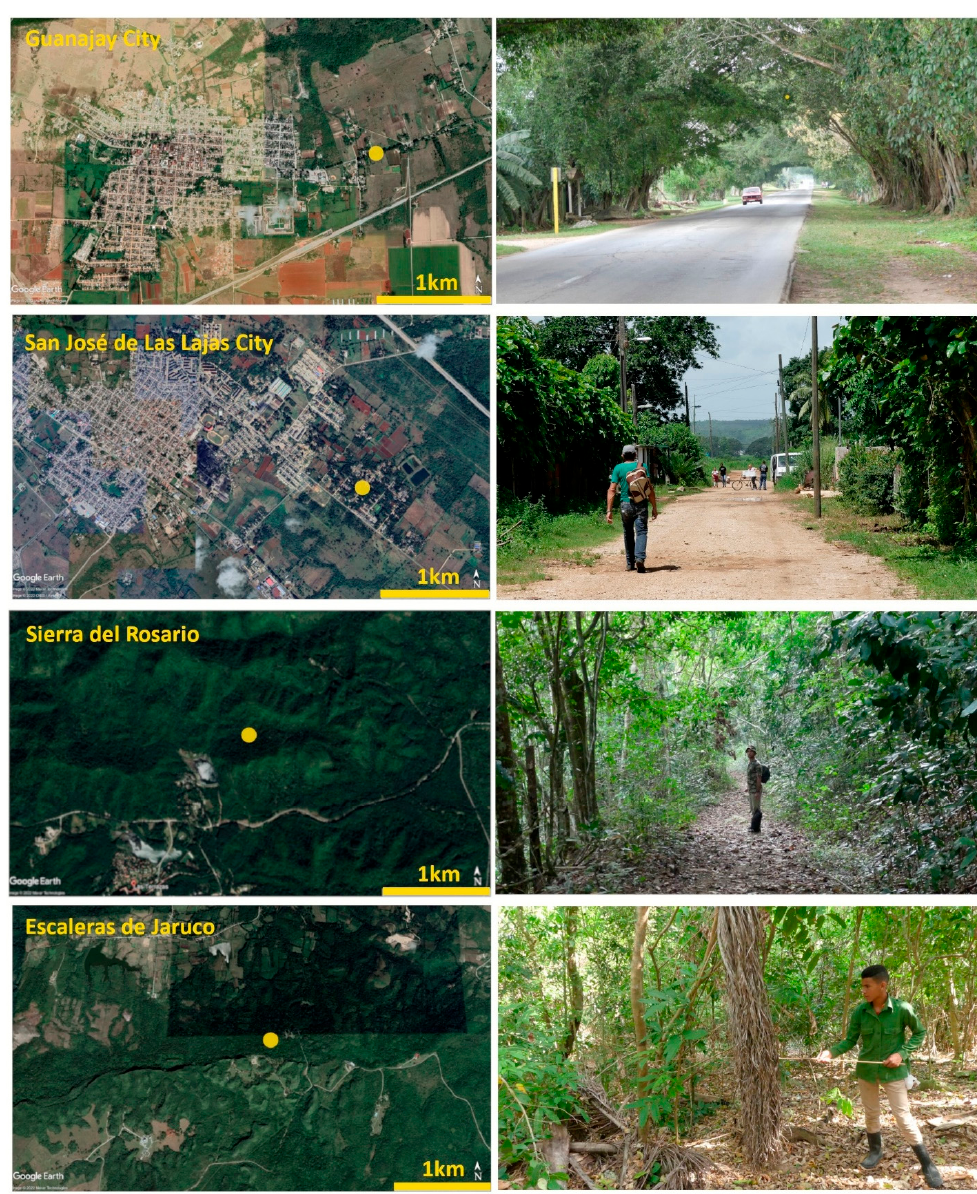
Figure 1. Locations of sampled sites (yellow points) during the capture-mark-recapture study of suburban and forest populations of Anolis homolechis ( left ), and representative photos of the habitat at each location ( right ).